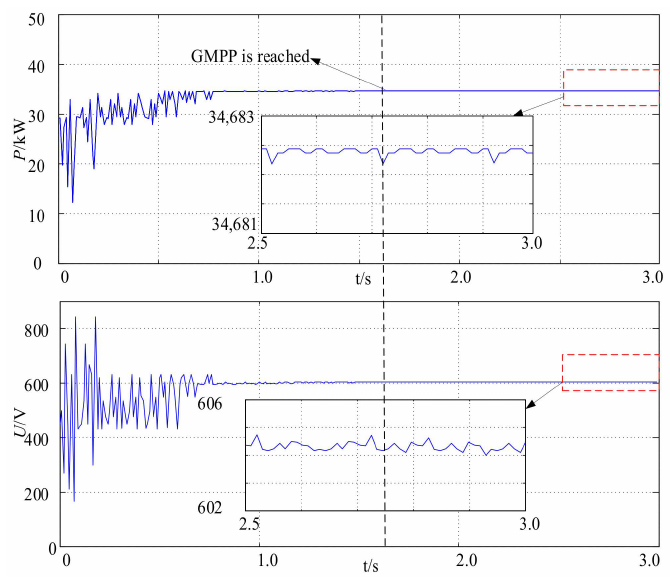
Figure 7. Voltage and power waveforms of FA for case 1 if GMPP occurs at middle.